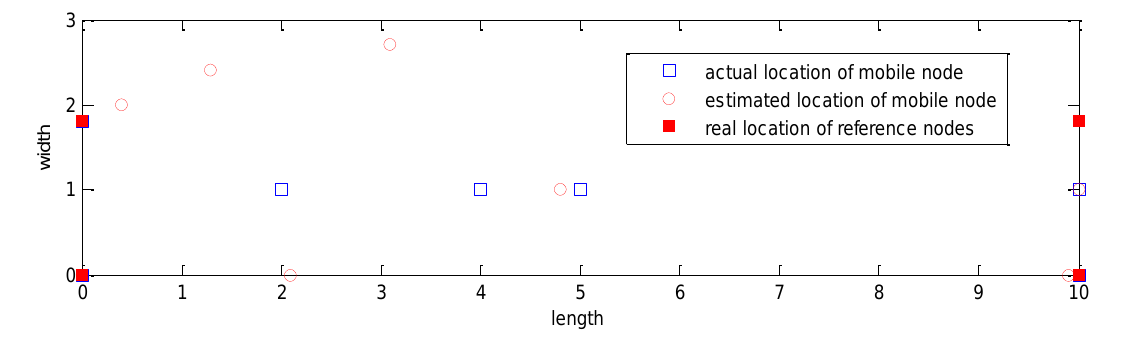
Figure 13. Static positioning performance, A = 40, n = 3.875.